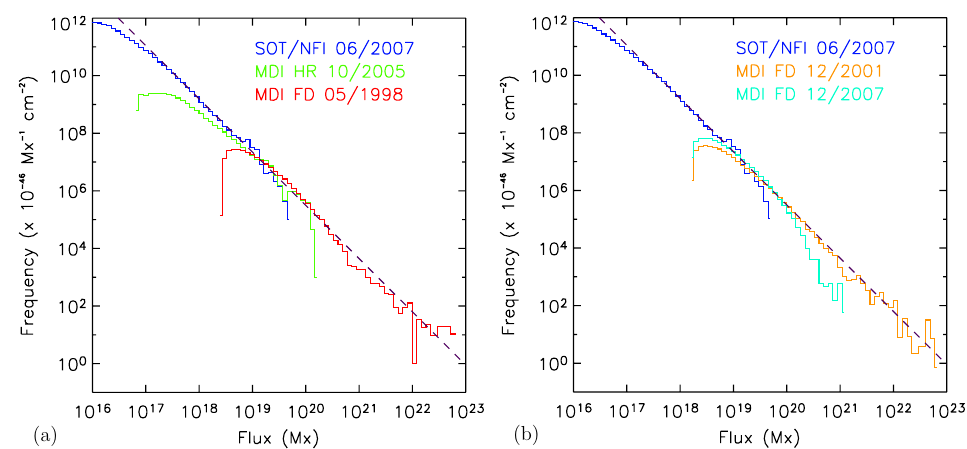
Figure 4: (a) Histograms of magnetic feature fluxes observed in the SOT data (blue), MDI high-resolution data (green), and 1998 May MDI full-disk data (red). (b) As (a), except here the lines are SOT data (blue) – for comparison – 2001 December (orange) and 2007 December (cyan) MDI full-disk data. The dashed line in both graphs is a fit to the data in (a) and has slope –1.85. These histograms show all feature fluxes between 2 × 10 17 and 10 23 Mx, regardless of flux amount, follow the same power-law distribution. Image reproduced with permission from Parnell et al. (2009), copyright by